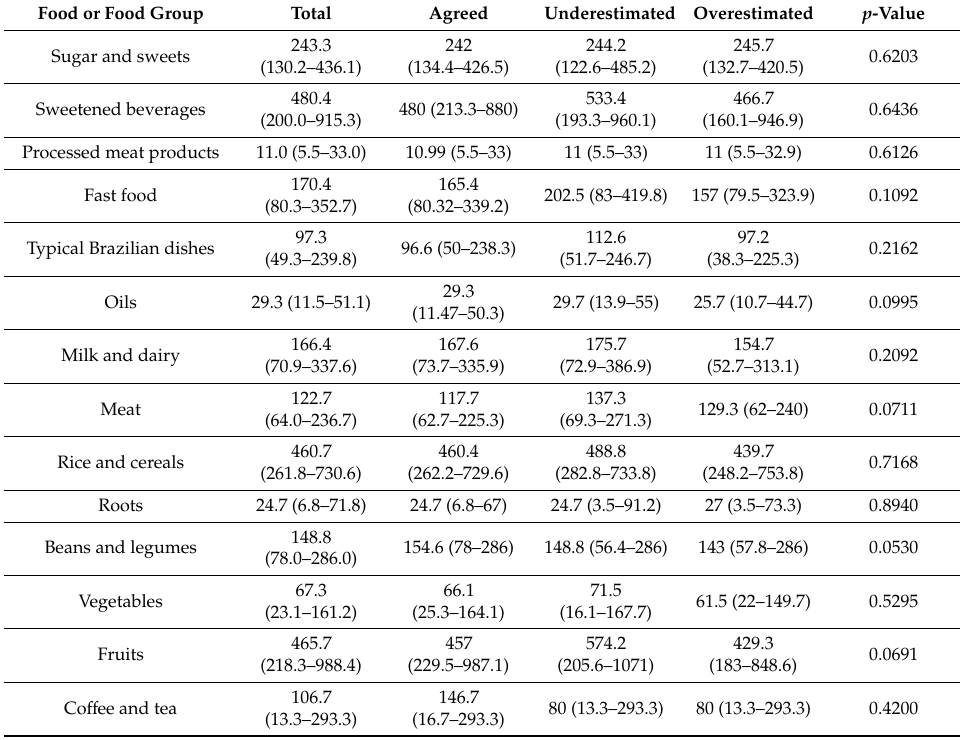
Table 2. Consumption of food groups according to divergence between measured and perceived weight in